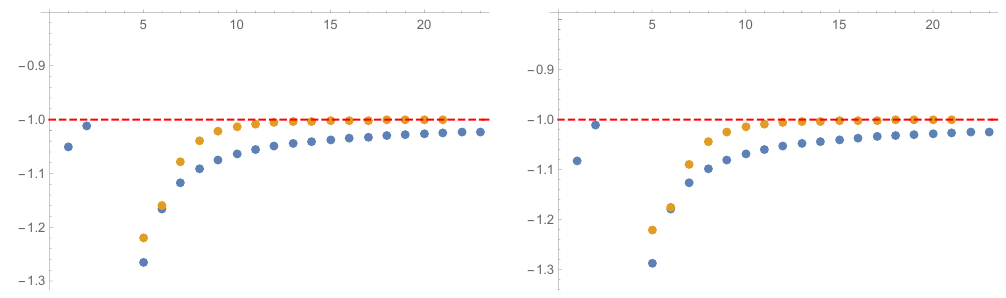
Figure 6 . The (cid:12)gure in the left (respectively, right) shows the sequence (3.29) and its second Richardson transform for the SU( N ) PCF, where N = 2 and N = 3, respectively. The horizontal dashed line is the expected value 1. (cid:0)